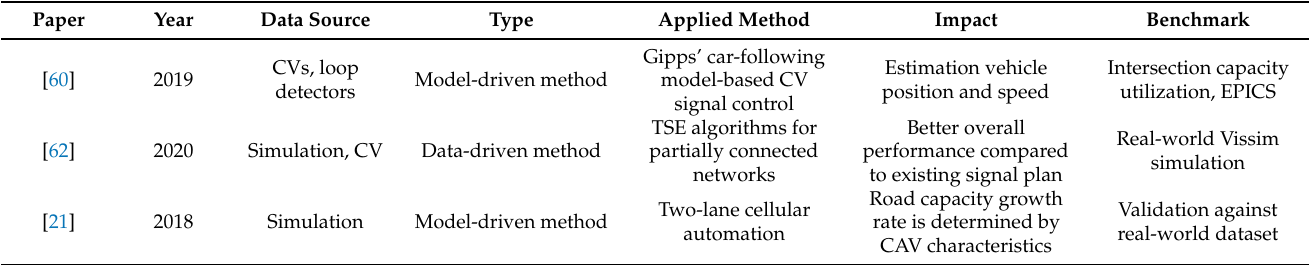
Table 2. Tabular overview of referenced papers regarding the impact of mixed traffic flows on